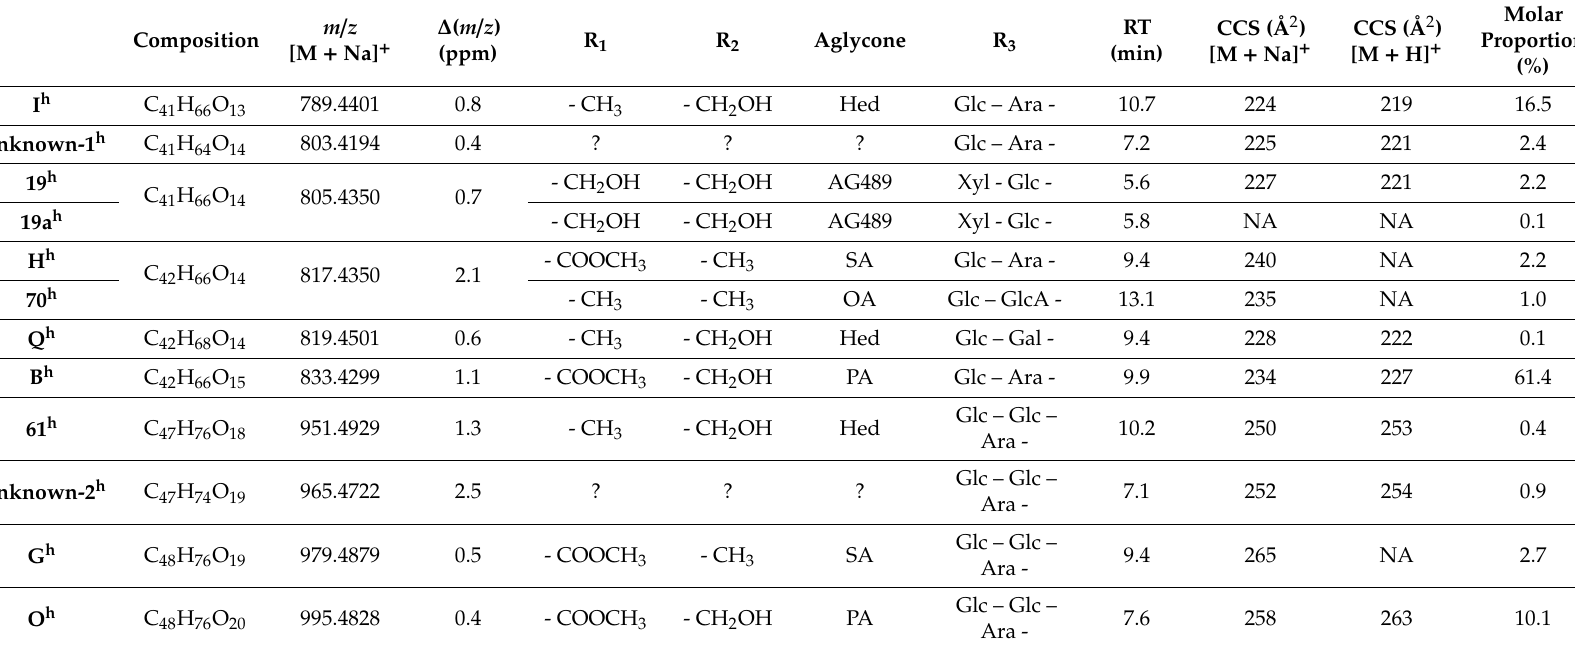
Table 2. Microwave-assisted alkaline hydrolysis (5min, pH 10, 150 ◦ C) of Chenopodium quinoa saponin extract: identification by MS-based methods of the saponin content. Hed, SA, OA and PA stand respectively for hederagin, serjanic acid, oleanic acid, and phytolaccagenic acid. AG489 corresponds to the aglycone #489 as defined in [6] and presented in Figure 3. RT stands for Retention Time in LC-MS experiments. CCS correspond to collision cross sections determined using traveling wave (TW) ion mobility with nitrogen as the bu ff er gas and converted in CCS against Helium using a calibration procedure [31], namely TW CCS N2 → He using the newly introduced nomenclature [33]. The Molar Proportion (% in the hydrolyzed quinoa husk extract) of each saponin is estimated based on the ion signal ratios as determined by mass spectrometry experiments (LC-MS), with hederacoside C as an external